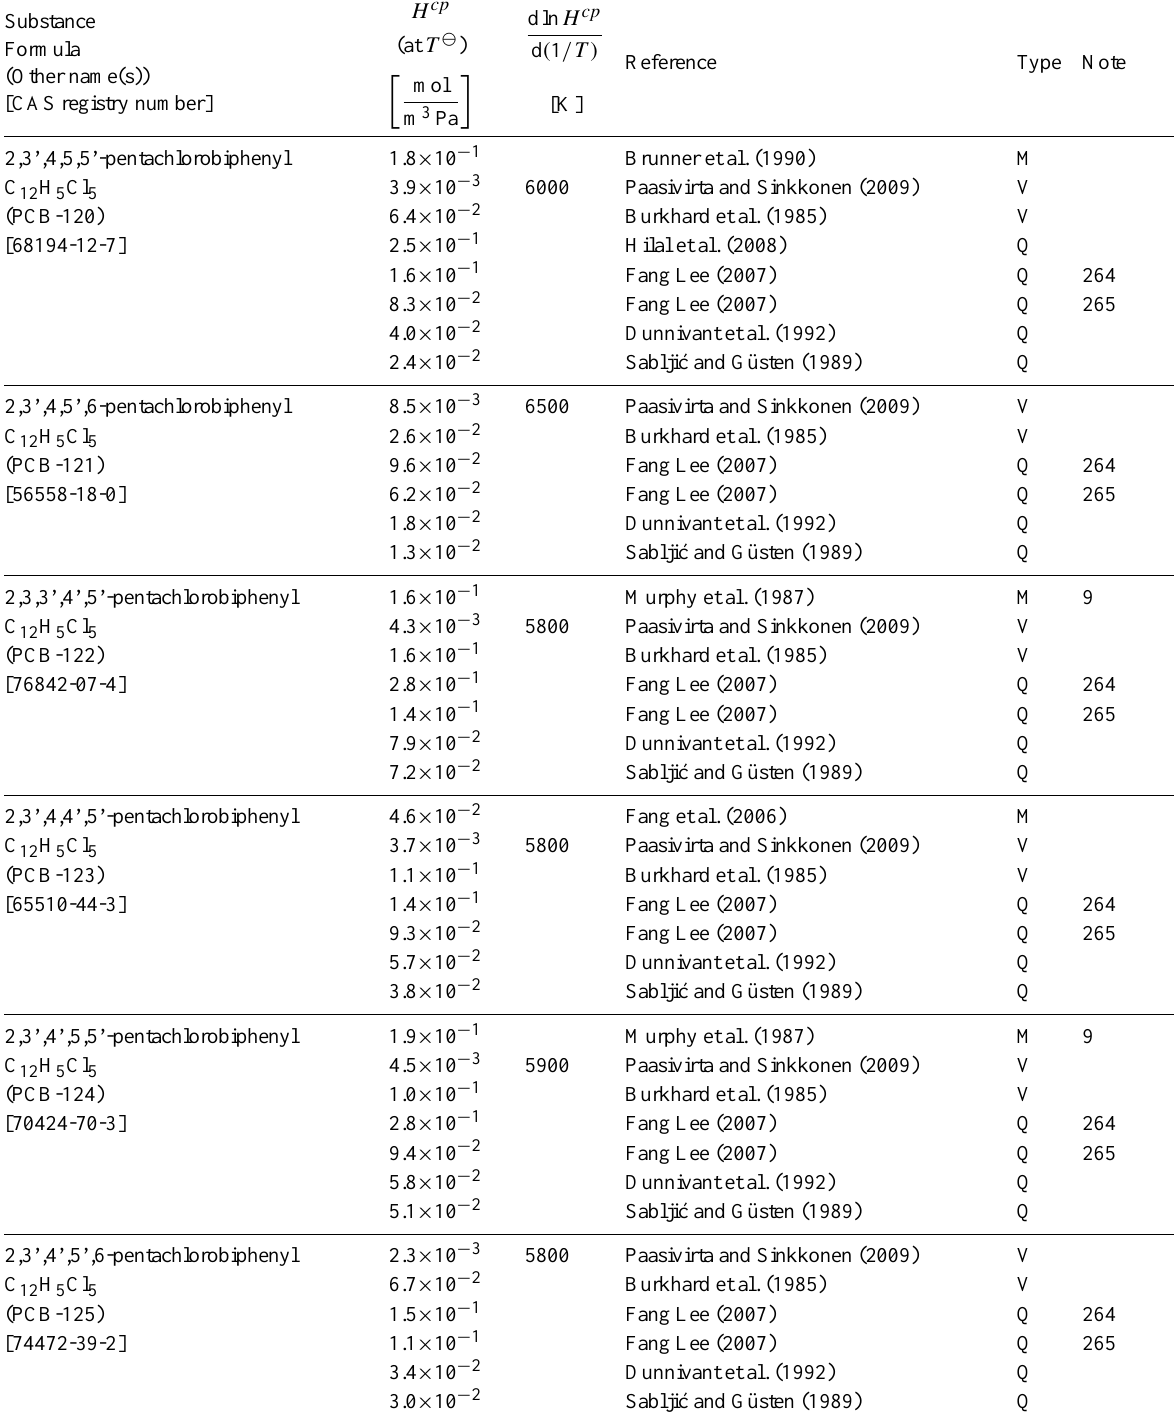
Table 6: Henry’s law constants for water as solvent